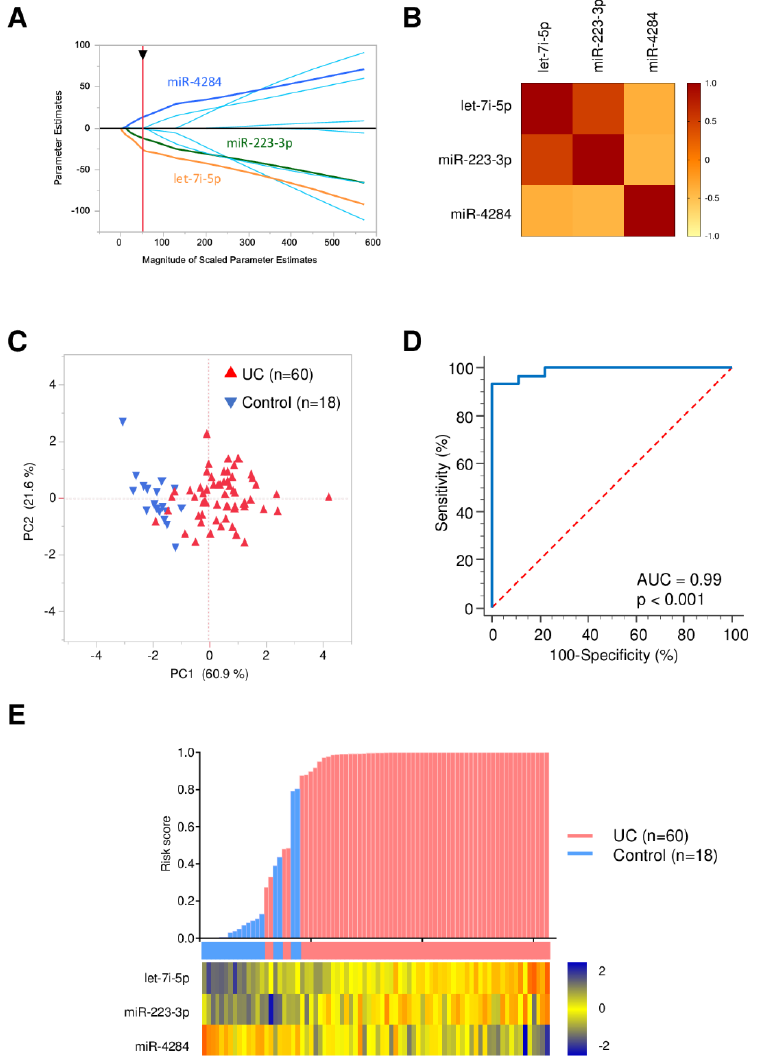
Figure 2. Diagnostic accuracy of 3-miRNA panel for identifying UC patients. ( A ) The adaptive LASSO model; ( B ) A correlation matrix displaying the Spearman’s rank correlation coefficient for each pair of three selected miRNAs; ( C ) Principal component analysis illustrating the good separation of UC-patient group and control group; ( D ) ROC curves for detecting UC patients using 3-miRNA panel; ( E ) A waterfall plot representing risk score of each patient. Red and blue columns indicate UC patients and controls, respectively. A heat map illustrating expression levels of the three candidate miRNAs expressed differentially between UC patients and controls.